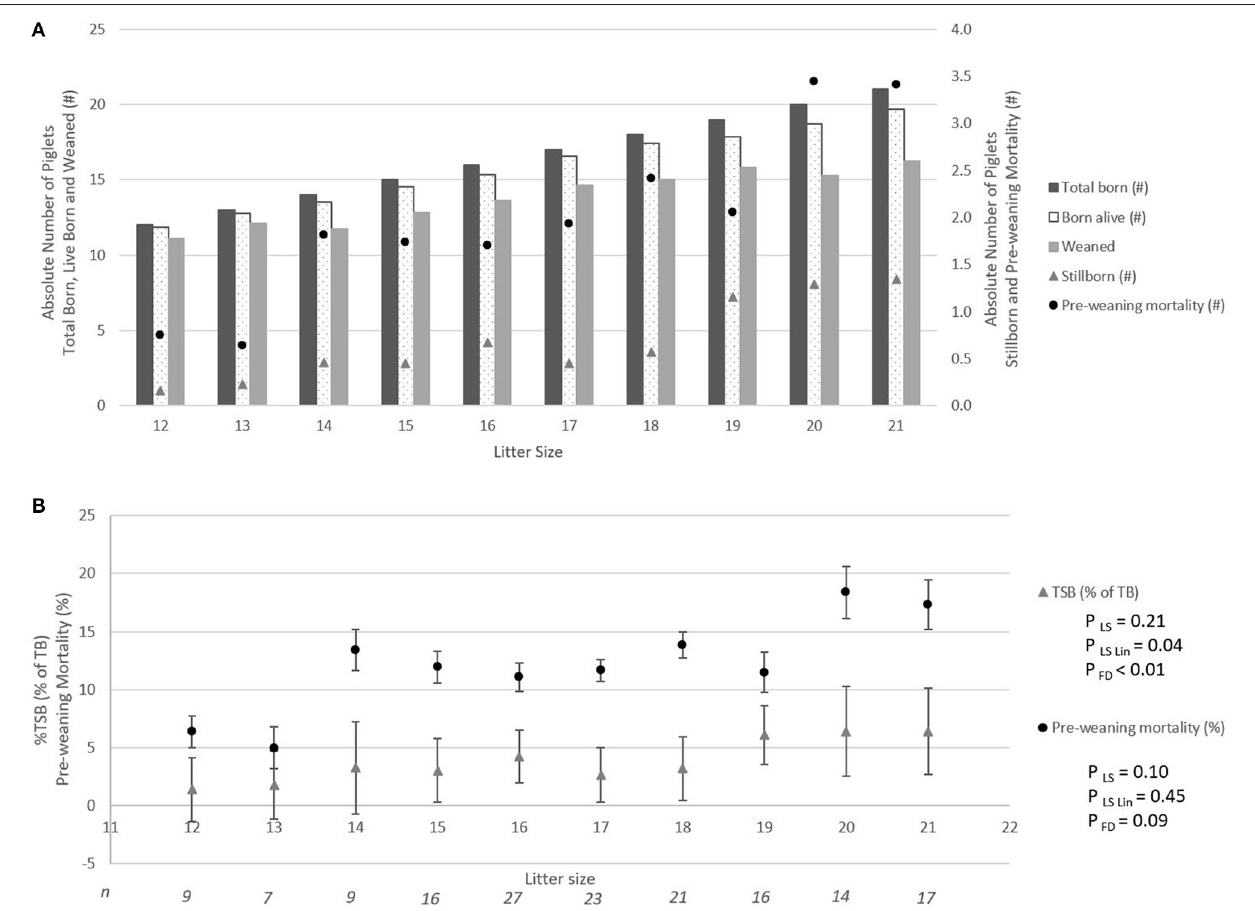
FIGURE 2 | The absolute number of piglets born in total, born alive, stillborn, lost due to pre-weaning mortality, and weaned per litter size (A) , and incidence of stillbirth ( N ) and pre-weaning mortality ( • ) per litter size (LSmeans ± SEM) (B) . Analyses performed on individual litters. p LS is the p -value for the fixed effect of litter size. p LSLin is the p -value for the linear effect of litter size, and p FD is the effect of farrowing duration class. N, number of litters per litter size. # Absolute number.